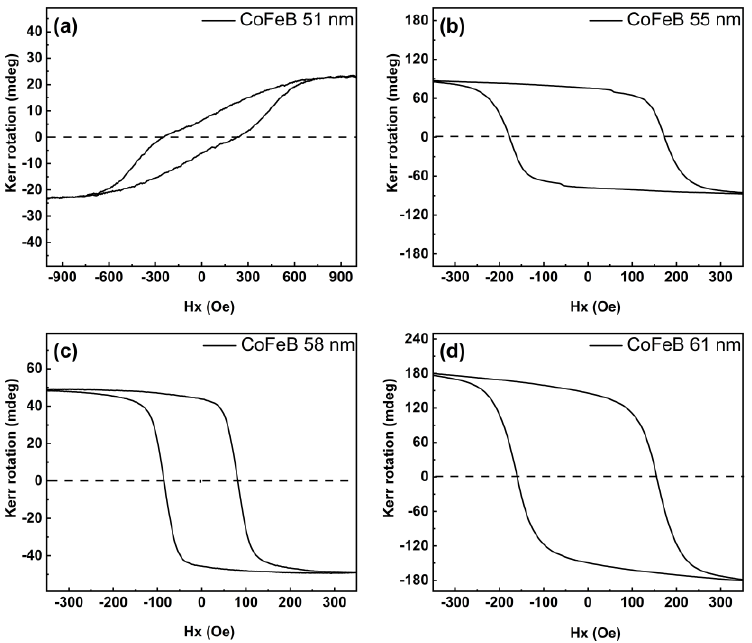
Figure 6. s-polarization L-MOKE hysteresis loops of CoFeB/AAO thin films with CoFeB layer thicknesses of ( a ) 51, ( b ) 55, ( c ) 58, and ( d ) 61 nm, excited at a laser with wavelength of 660 nm and an inducing angle of 45°.